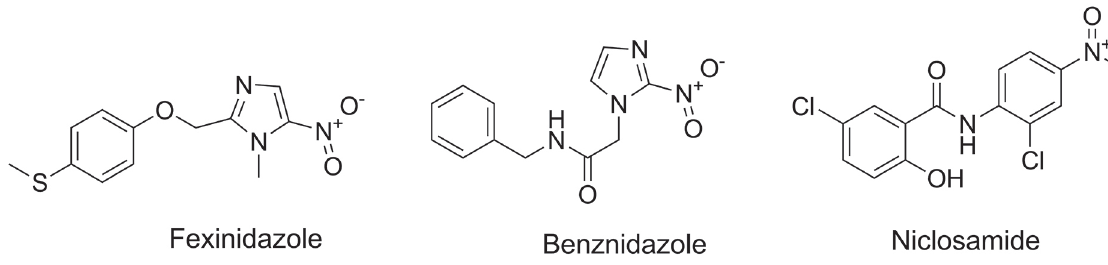
FIGURE 3 – Examples of nitro-aromatic drugs.